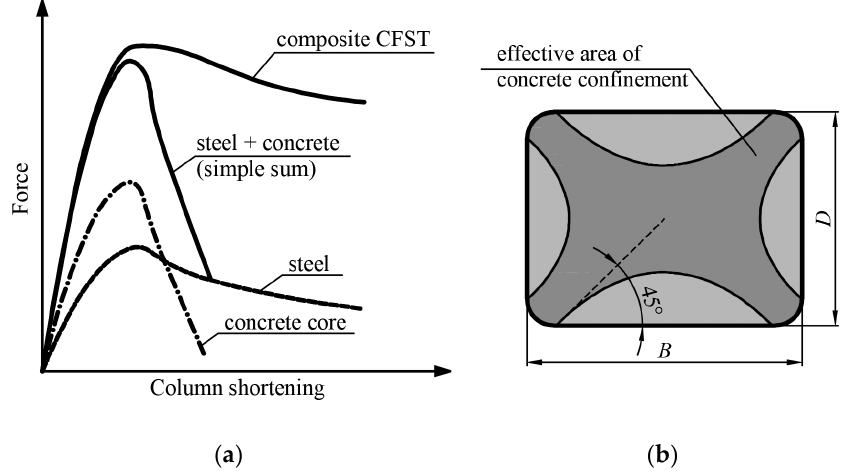
Figure 3. ( a ) Axial compressive behavior of CFST steel, concrete and CFST stub columns, based on [36]; ( b ) effectively confined concrete in a rectangular column, based on